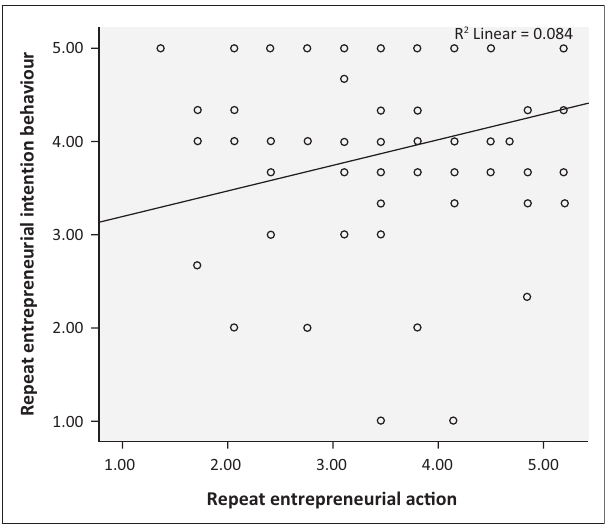
FIG URE 4: Scatter plot showing the relationship between recurring entrepreneurial intention behaviours and recurring entrepreneurial action.